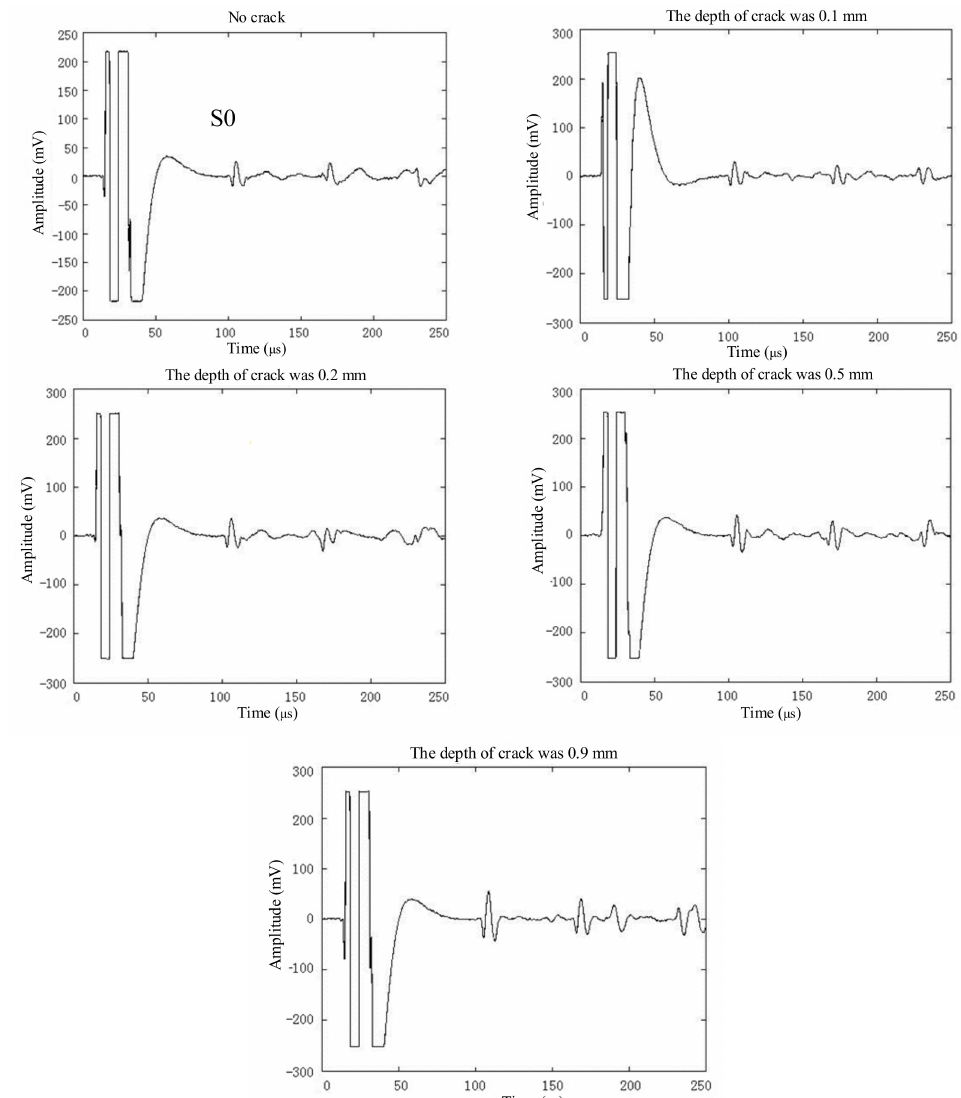
Figure 9. The ultrasonic waves received by the EMAT during the scanning inspection.